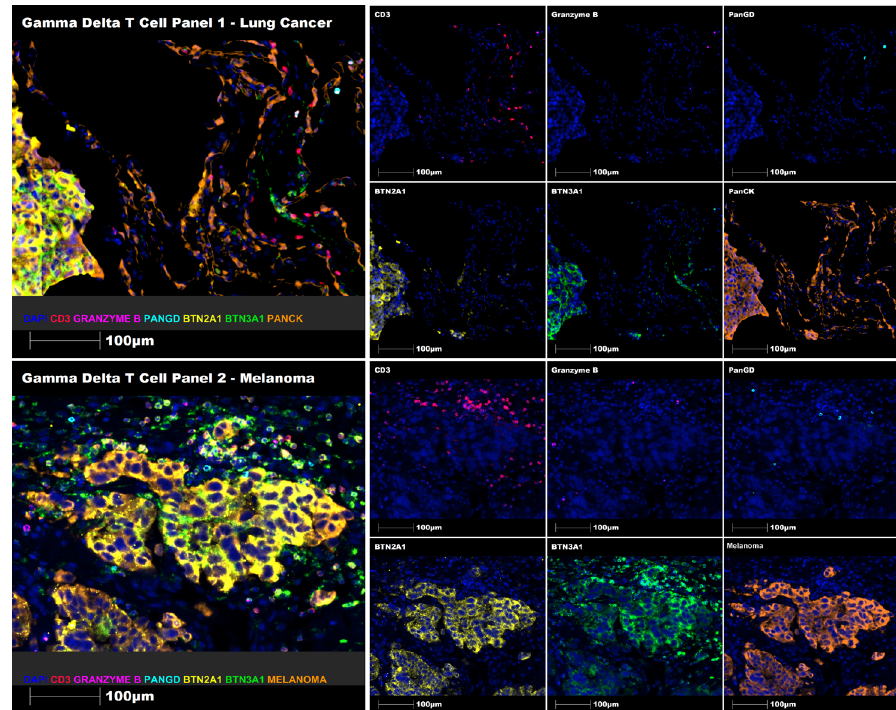
Figure 3. Multiplex staining of γδ T cell panels 1 (upper panel) and 2 (lower panel) using representative human lung cancer and melanoma FFPE tissue sections, respectively. Representative regions of interest showing merge and single staining for panel 1: CD3 (red), granzyme B (magenta), Pan-γδ (cyan), BTN2A1 (yellow), BTN3A1 (green), and PanCK (orange) antibodies with DAPI (blue) counterstain (upper immune-fluorescence panel); and panel 2: CD3 (red), granzyme B (magenta), Pan-γδ (cyan), BTN2A1 (yellow), BTN3A1 (green) and melanoma cocktail (orange) antibodies with DAPI (blue) counterstain (lower immune-fluorescence panel). All images were taken at 20× magnification, and scale bars indicate 100